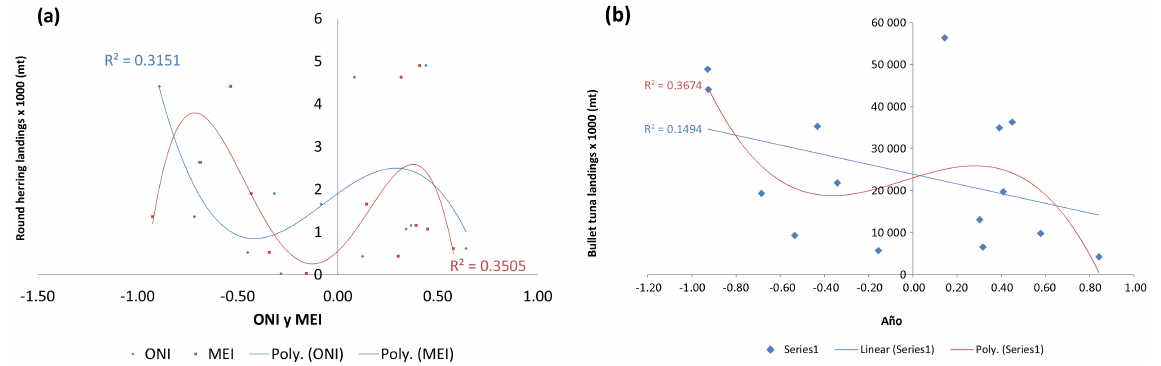
Figure 5. (a) Round herring (1981–2012); polynomial regression ( n = 4). (b) Bullet tuna (2000–2012) vs. MEI. Polynomial degree ( n = 3).